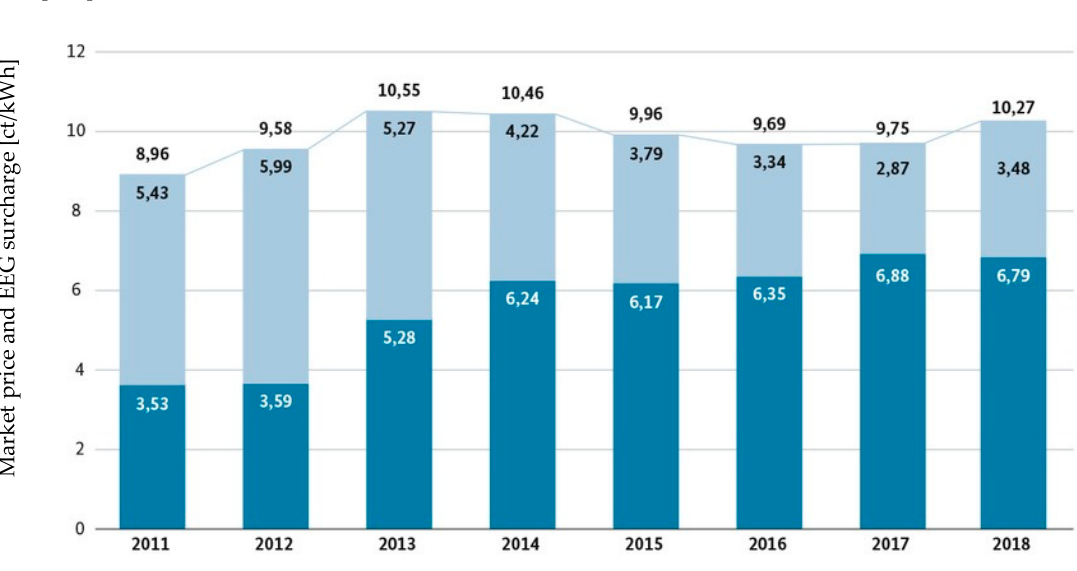
Figure 5. Sum of market price for electricity and EEG surcharge 2011–2018 [112].